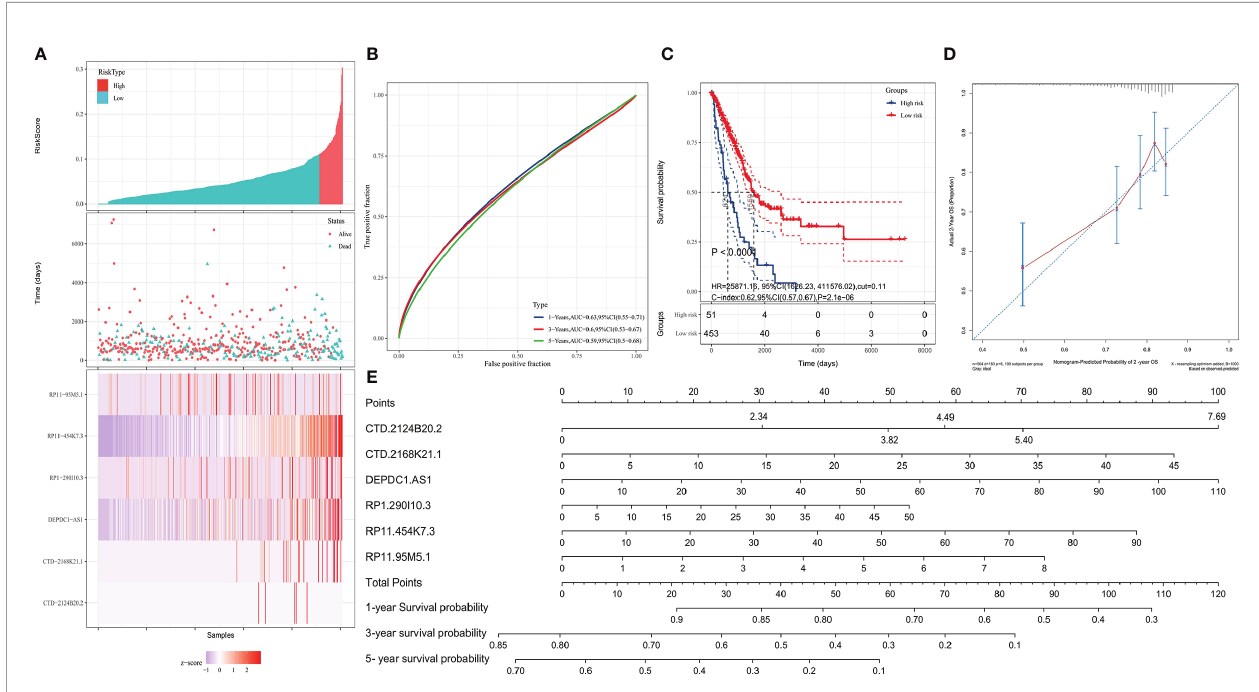
FIGURE 2 | Validation of the prognostic model. High- and low-risk groups were divided according to the lncRNA-associated risk score of OS (LARSO) value. (A) The histogram, scatter plot, and heat map showed the risk grouping, patient survival status, and the expression of the six lncRNAs, respectively. (B) Receiver operating characteristic (ROC) curves were shown at 1, 3, and 5 years based on the LARSO scores and prognosis of LUAD patients. (C) Kaplan – Meier survival curves were plotted: the overall survival time of patients in the high-risk group was signi fi cantly shorter than that in the low-risk group ( P < 0.0001). (D) Calibration curve: the x -coordinate was the probability of 2-year survival predicted by the model, and the y -coordinate represented the actual 2-year survival. (E) Column map: the 1-, 3-, and 5-year survival rates of patients could be predicted by scoring the expression level of the six lncRNAs. A log-rank test was used for survival